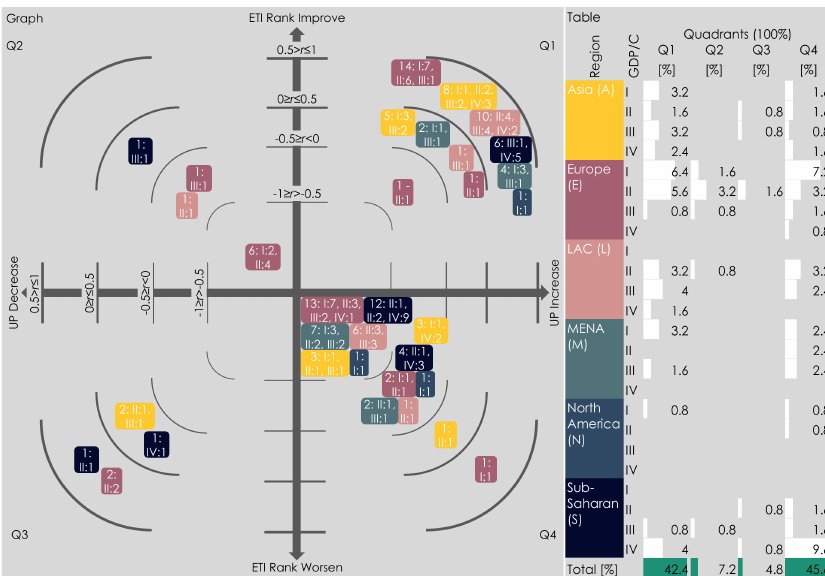
Figure 9. Variation of the 125 countries in the ETI ranking and the percentage of urban population (%UP) from 2014 to 2017. Source: Created by authors using data from